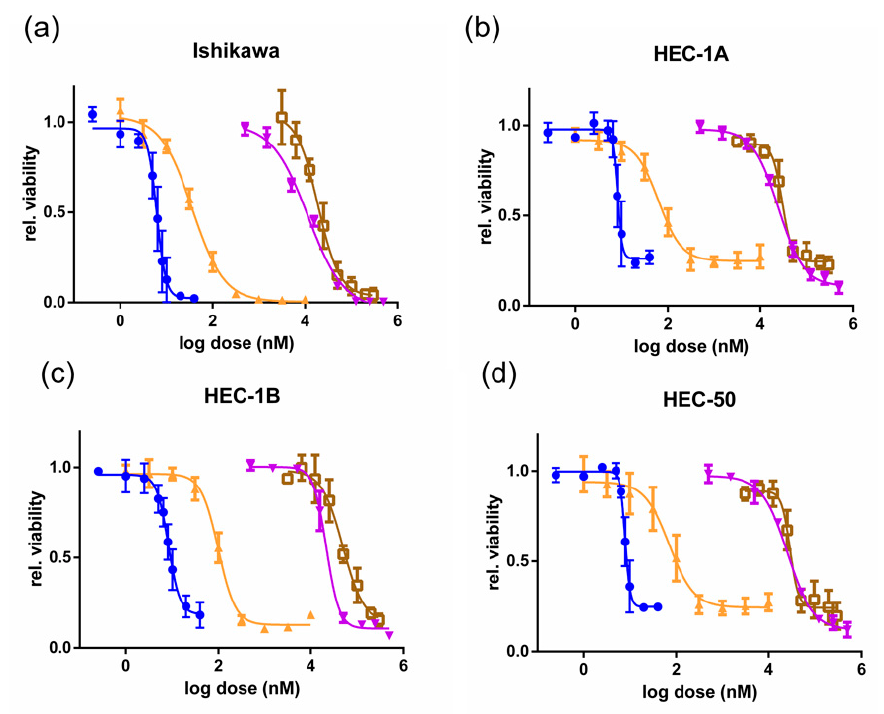
Figure 1. Type I and II endometrial cancer (EC) cell response to dinaciclib, flavopiridol, 6-dichloro-1- beta-D-ribofuranosylbenzimidazole (DRB), and cisplatin exposure. Dose–response experiments are shown following 72 h of treatment with dinaciclib (blue), flavopiridol (orange), DRB (brown), and cisplatin (purple) in the Type I EC cell line ( a ) Ishikawa and the Type II EC cell lines ( b ) HEC-1A, ( c ) HEC-1B, and ( d ) HEC-50. Viability was measured using a RealTime-Glo MT cell viability assay and is normalized to vehicle controls.